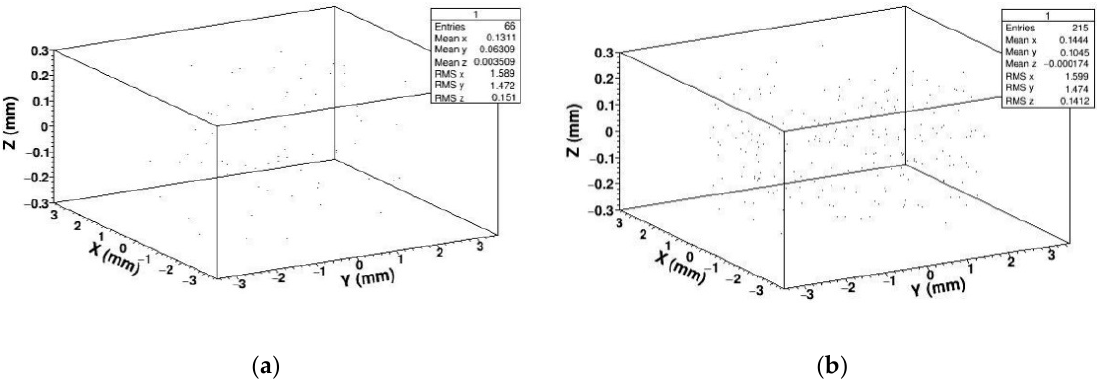
Figure 15. PKA spatial distribution in SDD generated by gammas: ( a ) PKA spatial distribution for 14 MeV gammas; ( b ) PKA spatial distribution for 20 MeV gammas.